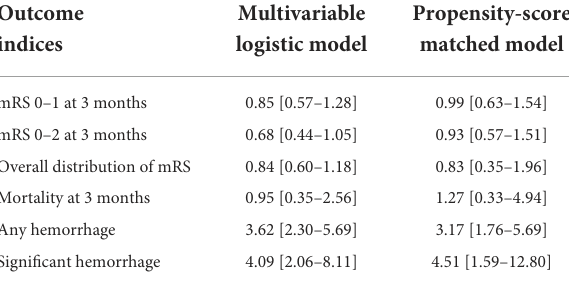
TABLE 2 Effectiveness and safety of EVT for mild